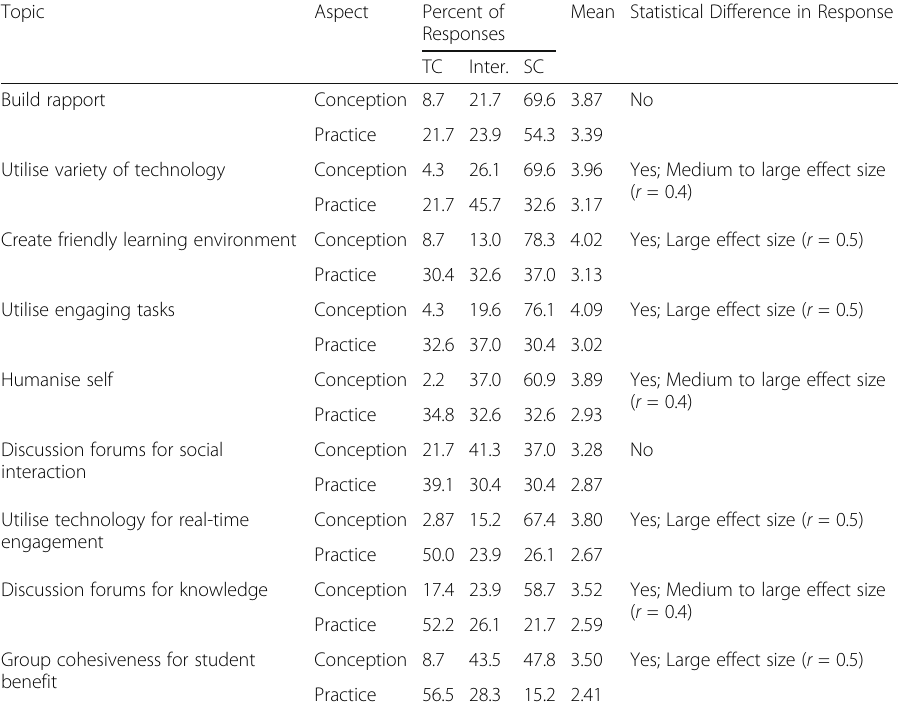
Table 7 Differences between conceptions of teaching and enacted practice Topic Aspect Percent of